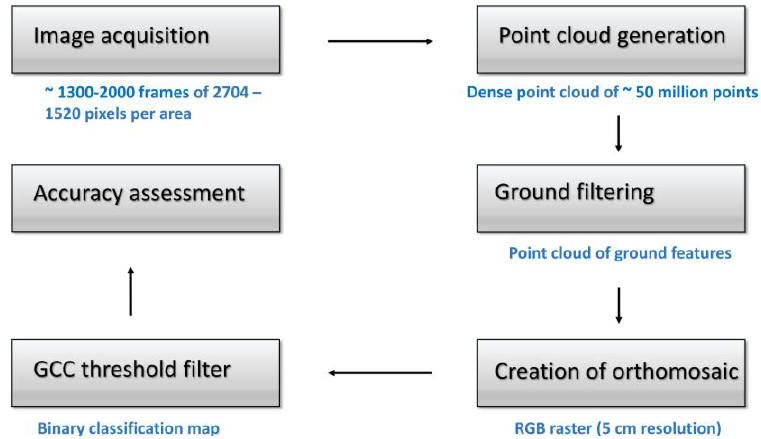
Figure 7. Workflow for processing UAV-acquired imagery into a binary classification map. Boxes indicate processing steps, blue text describes the data produced by each step.